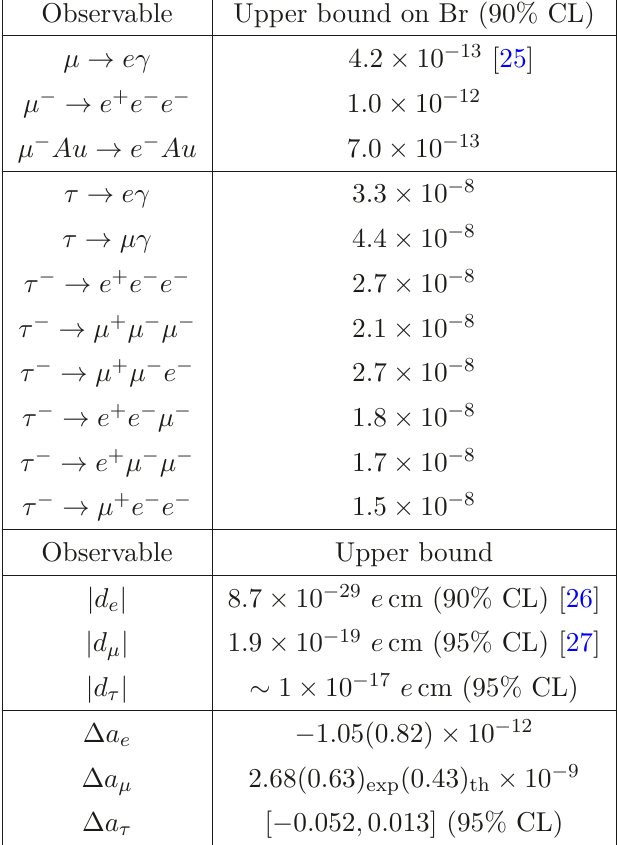
a SM . A in the EDM of the τ lepton − ∼